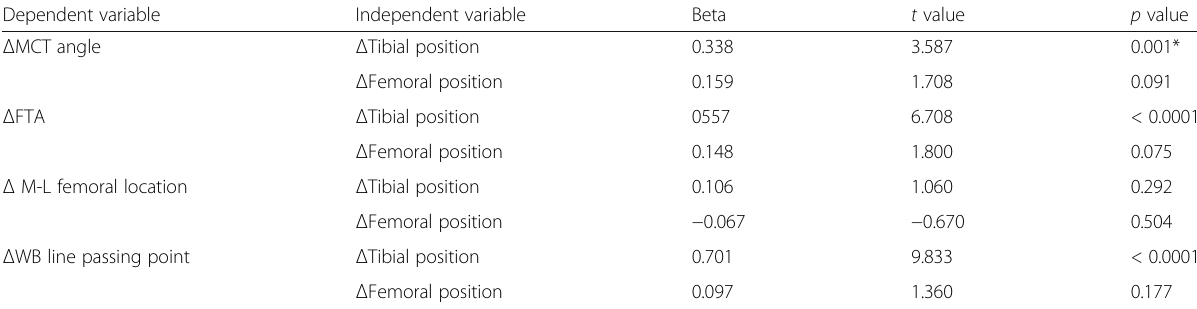
Table 4 Multiple linear regression